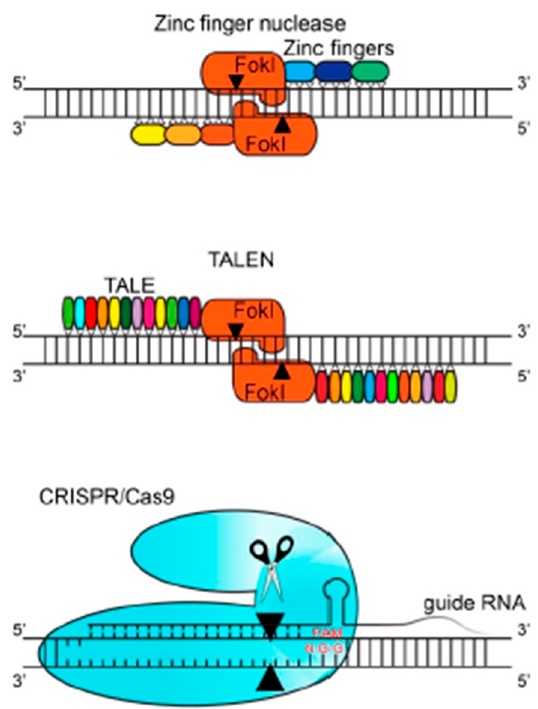
Figure 1. Overview of the diverse gene editing nucleases (ZFN, TALEN, CRISPR/Cas9). The black arrows illustrate the cleavage site of the DNA [15]. Table 1. Comparison of three significant genome editing tools—ZFNs, TALENs and CRISPR [9].